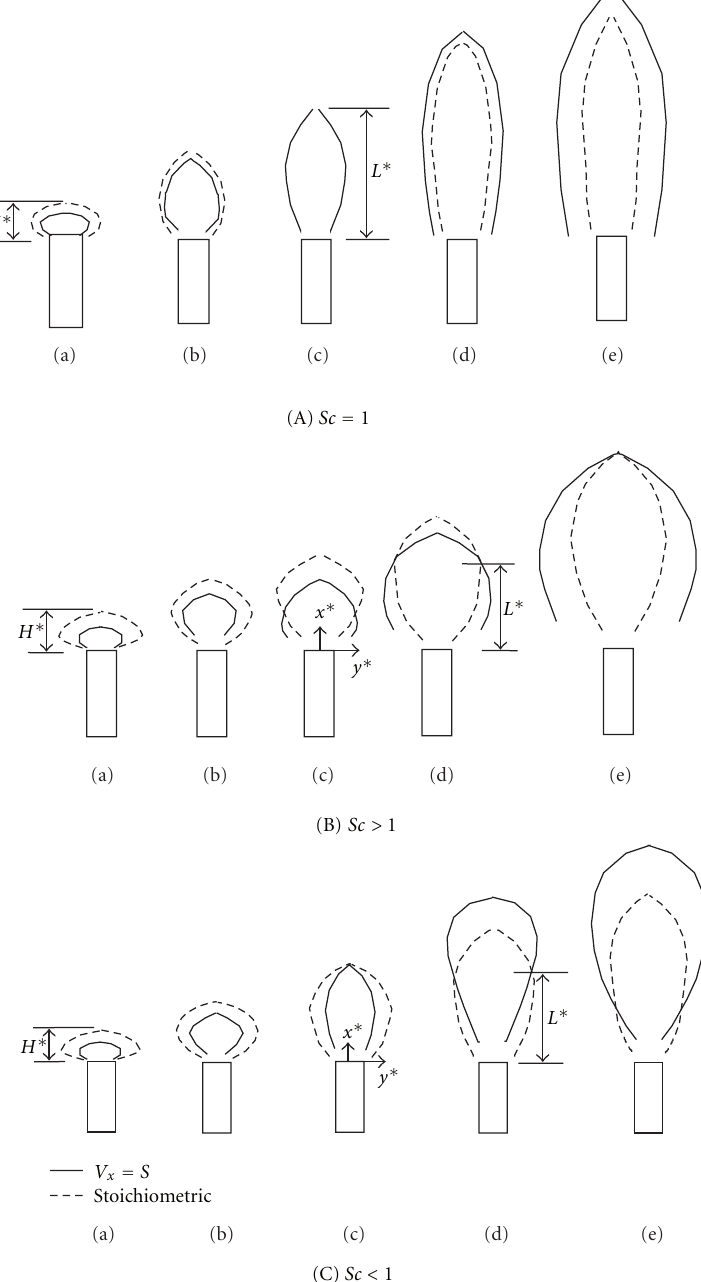
Figure 5: Stoichiometric (dashed) and flame speed (solid) contour growths with increasing Re and varying Sc .